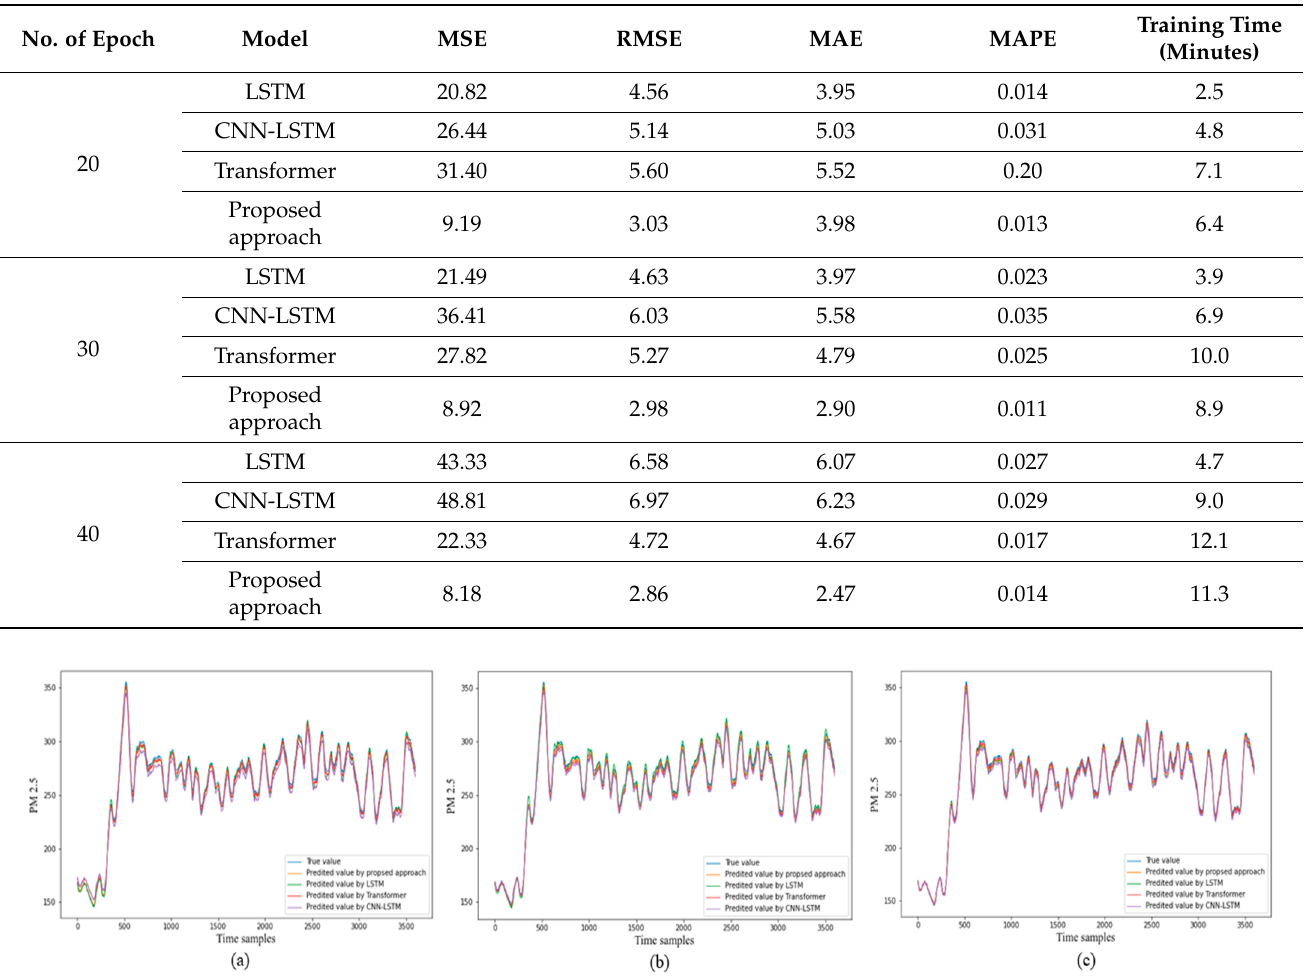
Table 4. The 1 h ahead forecasting performance of LSTM, CNN-LSTM, Transformer models, and our proposed approach (Single-Dense Layer BiLSTM).